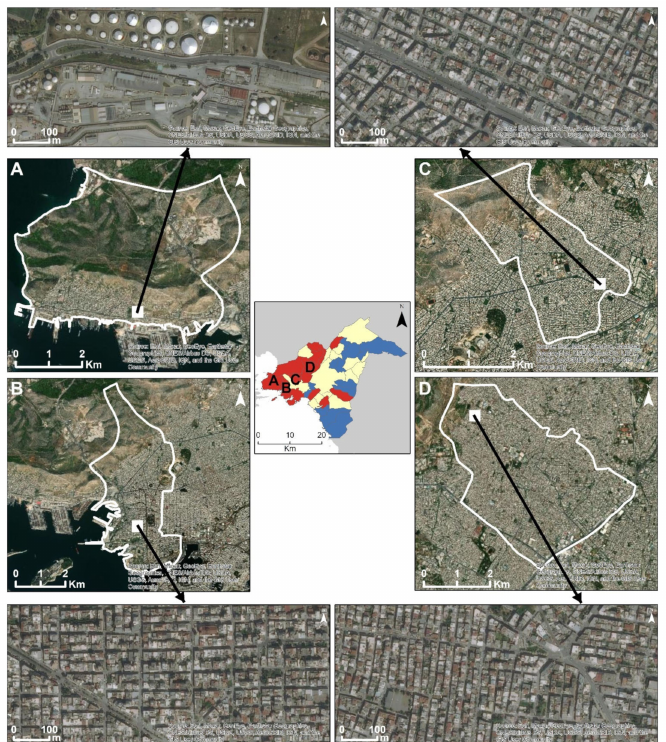
Figure 7. The urban background of disadvantageous municipalities. ( A ) Perama municipality,